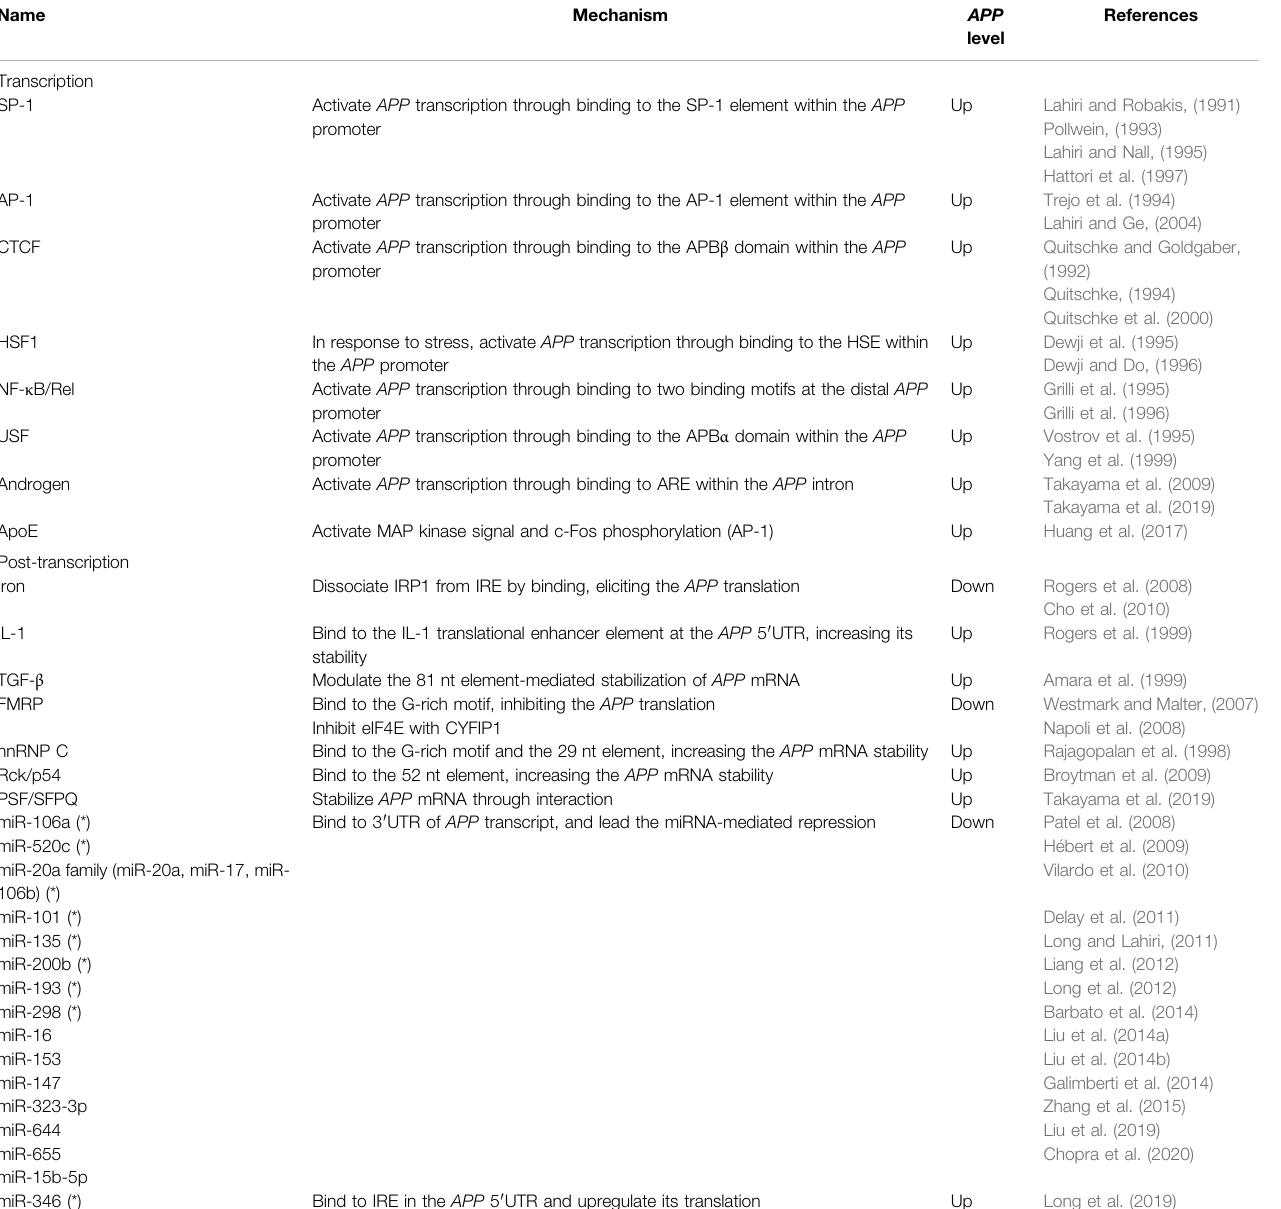
TABLE 1 | List of transcriptional and post-transcriptional regulators for the APP